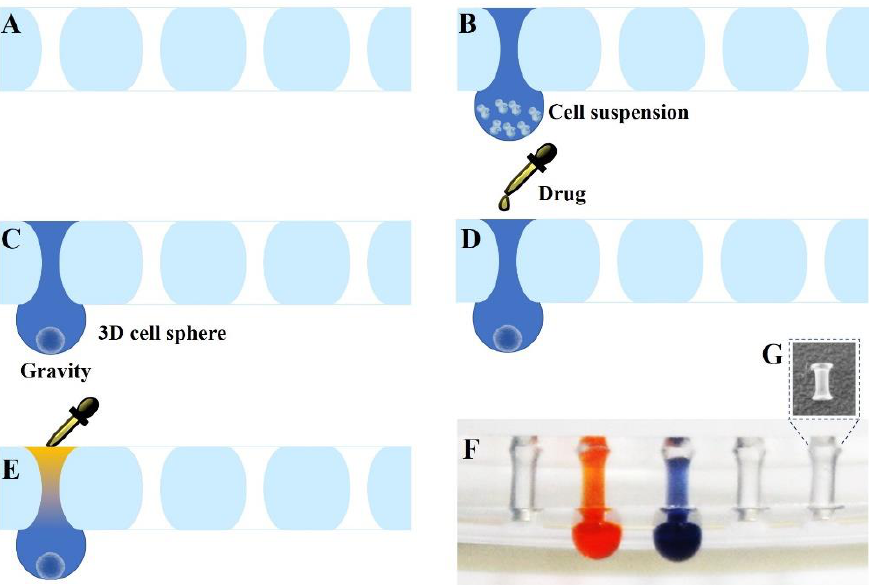
Figure 1. Diagram of the SimpleDrop chip. ( A ) The micro-hole array on a PDMS layer (3 mm thickness) punched by a flat needle. ( B ) Through the micro-holes, cell suspension forms a droplet. ( C ) Cells in the droplet spontaneously aggregate into spheres. ( D , E ) Drugs with different concentrations are added from the micro-holes for drug analysis. ( F ) Photographs of the SimpleDrop chip; the holes are waist type with wide ends and a narrow middle. ( G ) PDMS plug.